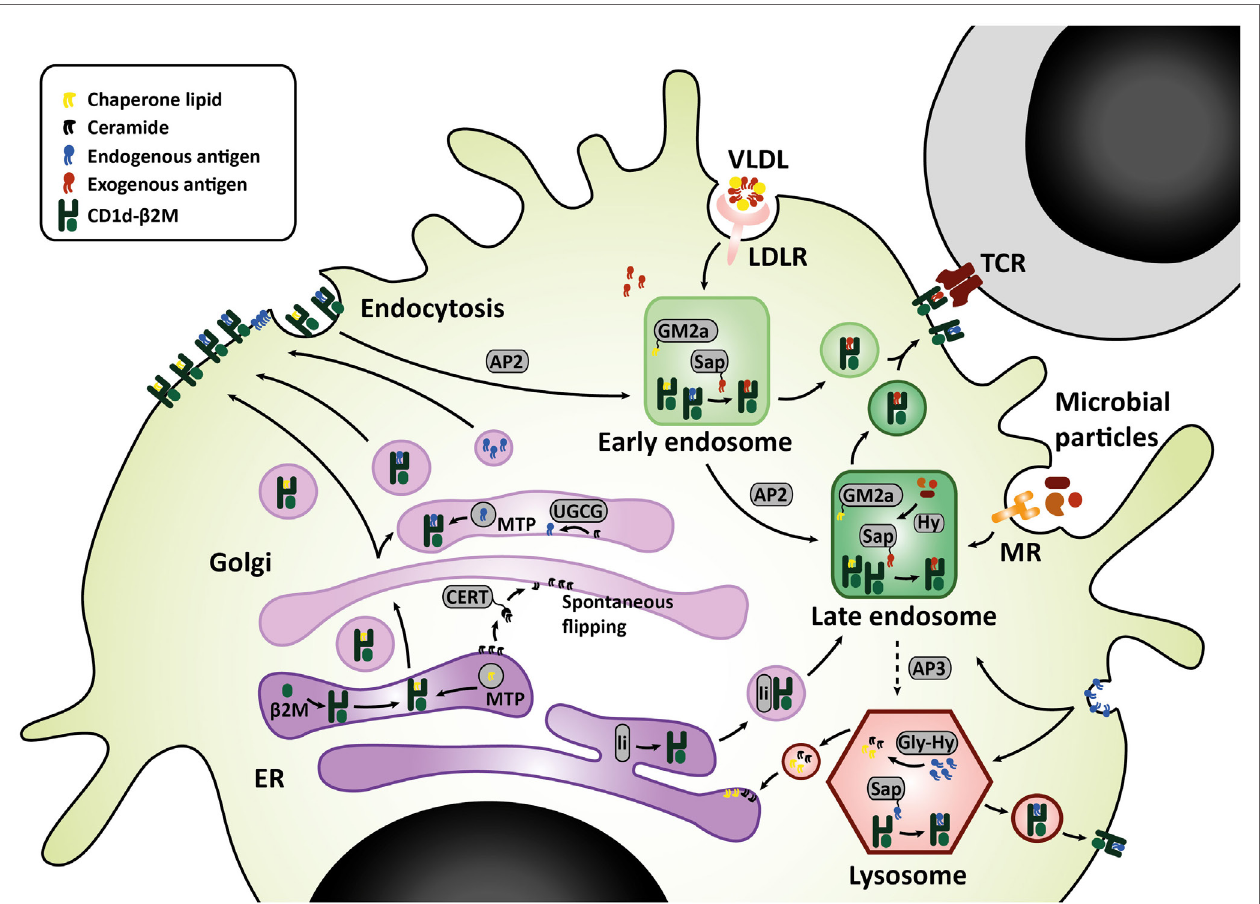
FiGURe 1 | CD1d lipid loading at the crossroads of glycosphingolipid metabolism. In the ER–Golgi pathway that is similar for mouse and human, CD1d heavy chains assemble with β 2M and chaperone lipids in the ER before transit to the cell surface. Alternatively, the Golgi complex produces GSL that are loaded onto CD1d by microsomal transfer protein, and may serve as endogenous lipid antigens. Ceramide precursors are transported to the Golgi by ceramide transfer protein (CERT). In the Golgi, UGCG and other glycosyltransferases convert ceramide into GSL. These GSL endproducts can be loaded onto CD1d, or transported to the plasma membrane in membrane-bound transport carriers. In the endolysosomal pathway, mouse CD1d1 may target the endosome and lysosome directly via interaction with sorting motifs adaptor protein 2 (AP2), which targets the endosomal compartment, and adaptor protein 3 (AP3), which targets the lysosomal compartment. Human CD1d is internalized via AP2 but cannot bind AP3. However, human CD1d can still be found in the lysosomal compartment. Possibly, ER-resident CD1d proteins gain access to the endolysosomal compartment via an auxiliary pathway, in conjunction with MHC class II-associated invariant chain (li). In the endolysosomal compartments, CD1d proteins are loaded with exogenous or endogenous lipid antigens, orchestrated by a variety of lipid transfer proteins including GM2 activator (GM2a), saposins A-D (Sap), and Niemann-Pick type C2 protein. Exogenous lipid antigens are delivered to the endosomal compartment via endocytosis of LDLR-associated glycolipids, MR-associated microbial lipids, and other scavenger receptors. Some exogenous lipids require processing into antigenic lipids before CD1d-loading, for example, through lipid hydrolases (Hy). Endogenous lipid antigens are delivered to the endolysosomal compartment via endocytosis of membrane-associated GSL, which can be loaded onto CD1d or degraded in lysosomes by glycohydrolases (Gly-Hy) and accessory proteins, before recycling to the ER (salvage pathway). Upon lipid antigen loading in the endolysosomal compartments, CD1d–lipid complexes recycle back to the cell surface for interaction with the invariant TCR on invariant natural killer T cells. Abbreviations: AP, adaptor protein; β 2M, β 2-microglobulin; ER, endoplasmic reticulum; Gly-Hy, glycohydrolase; GM2a, GM2 activator; GSL, glycosphingolipids; Hy, hydrolase; LDLR, LDL-receptor; Li, MHC class II-associated invariant chain; MR, mannose receptor; Sap, saposins; TCR, T-cell receptor; UGCG, UDP-glycose ceramide glucosyltransferase; VLDL, very-low-density